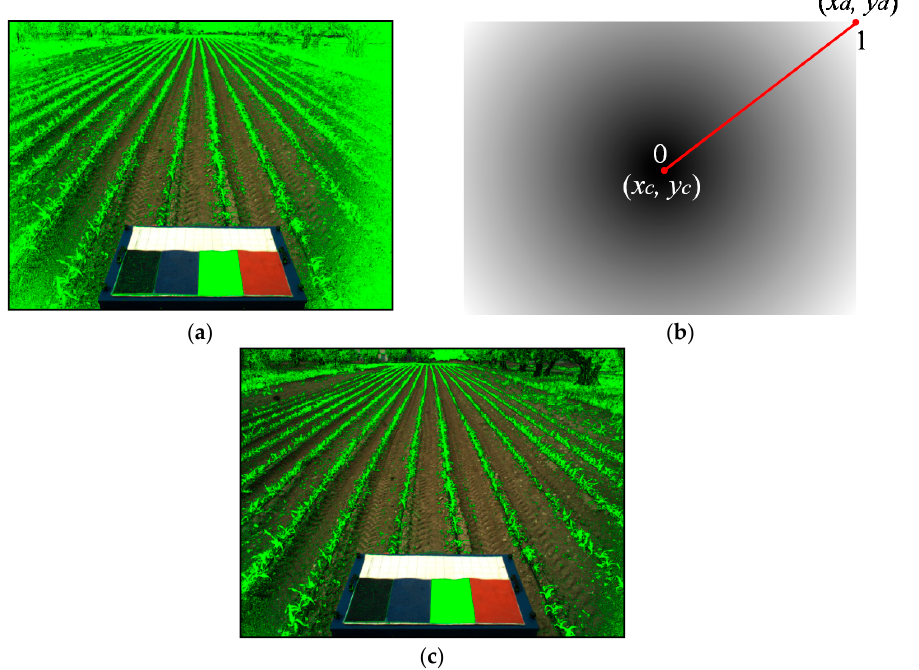
Figure 3. Vignetting: ( a ) effect with emphasis on the external parts; ( b ) correction mask; ( c ) corrected